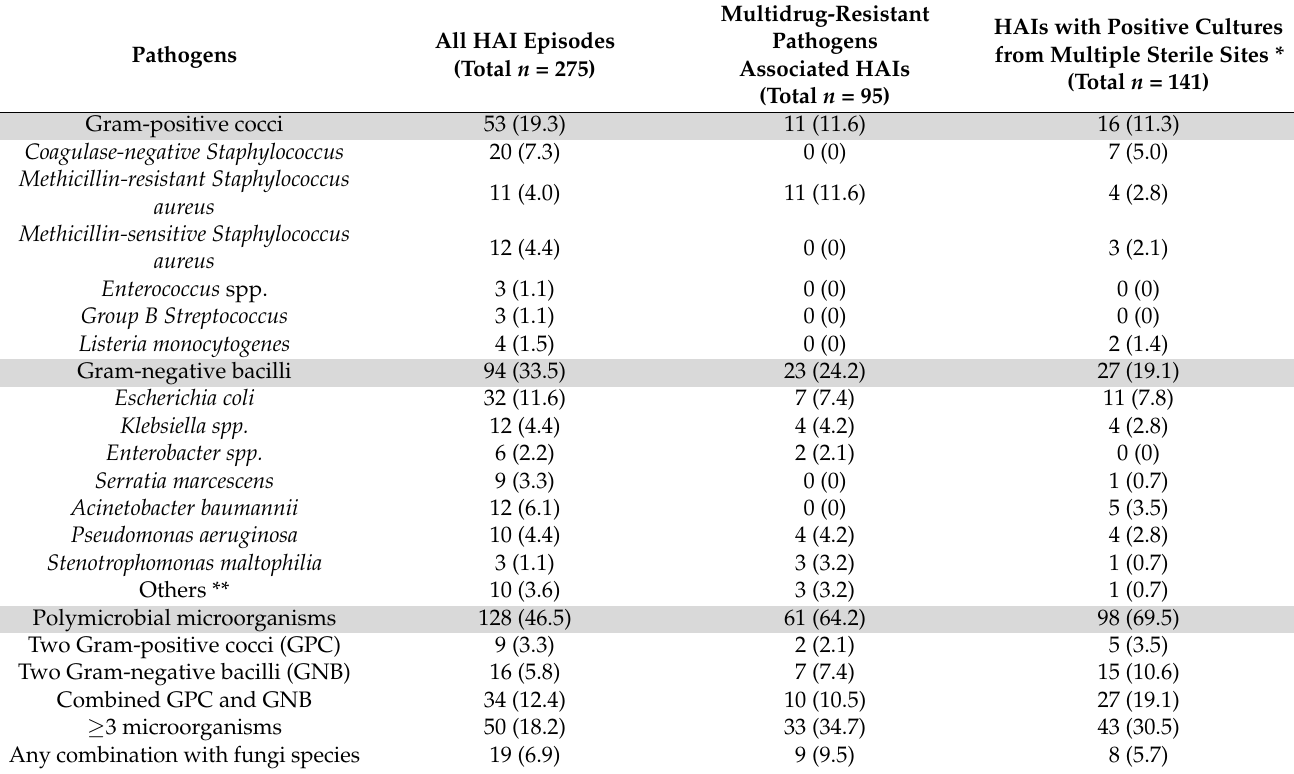
Table 1. Pathogen distribution of healthcare-associated infections (HAIs) in neonates with severe respiratory failure.